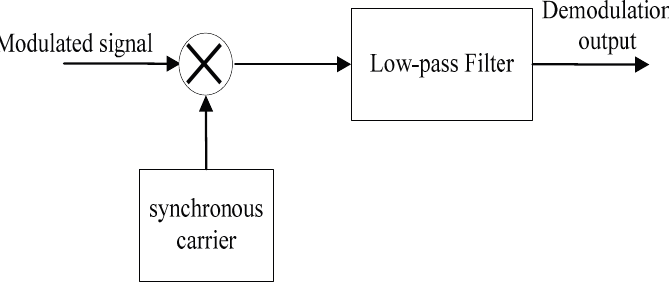
Figure 3. Block diagram of BPSK demodulation.